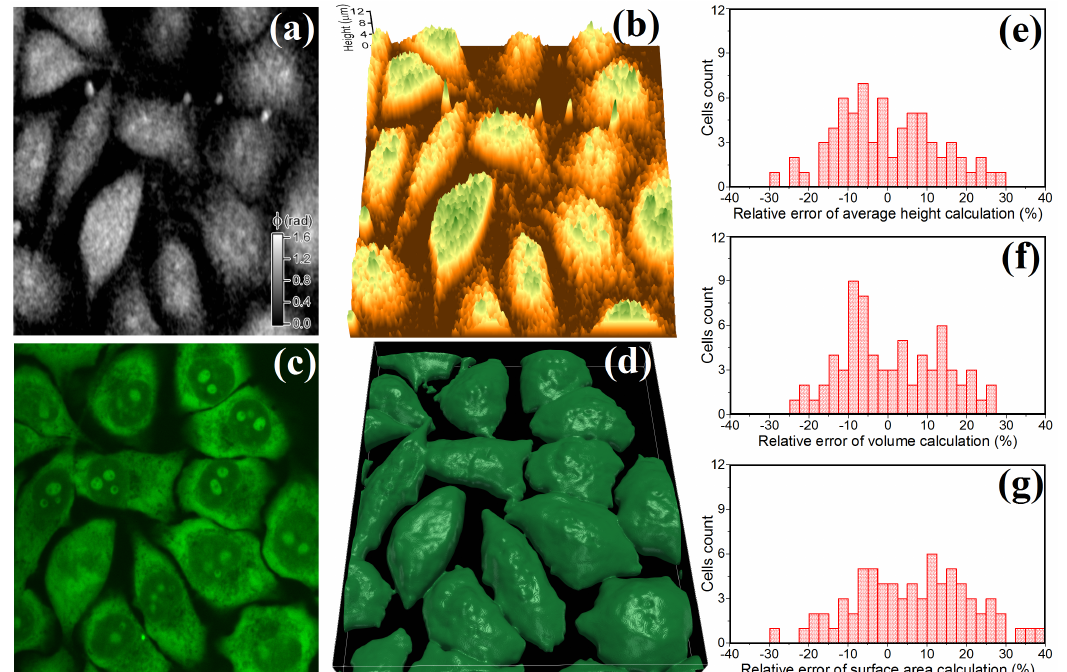
Figure 1. Examples of images of the same field of view in HeLa cell sample obtained by DHM and confocal fluorescence microscopy. ( a ) phase distribution obtained by DHM and ( b ) calculated height map; ( c ) XY-cross section image obtained using confocal fluorescence microscopy and ( d ) calculated 3D image. ( e – g ): statistical distributions of relative errors of average height h av ( e ), volume V ( f ) and surface area S surf ( g